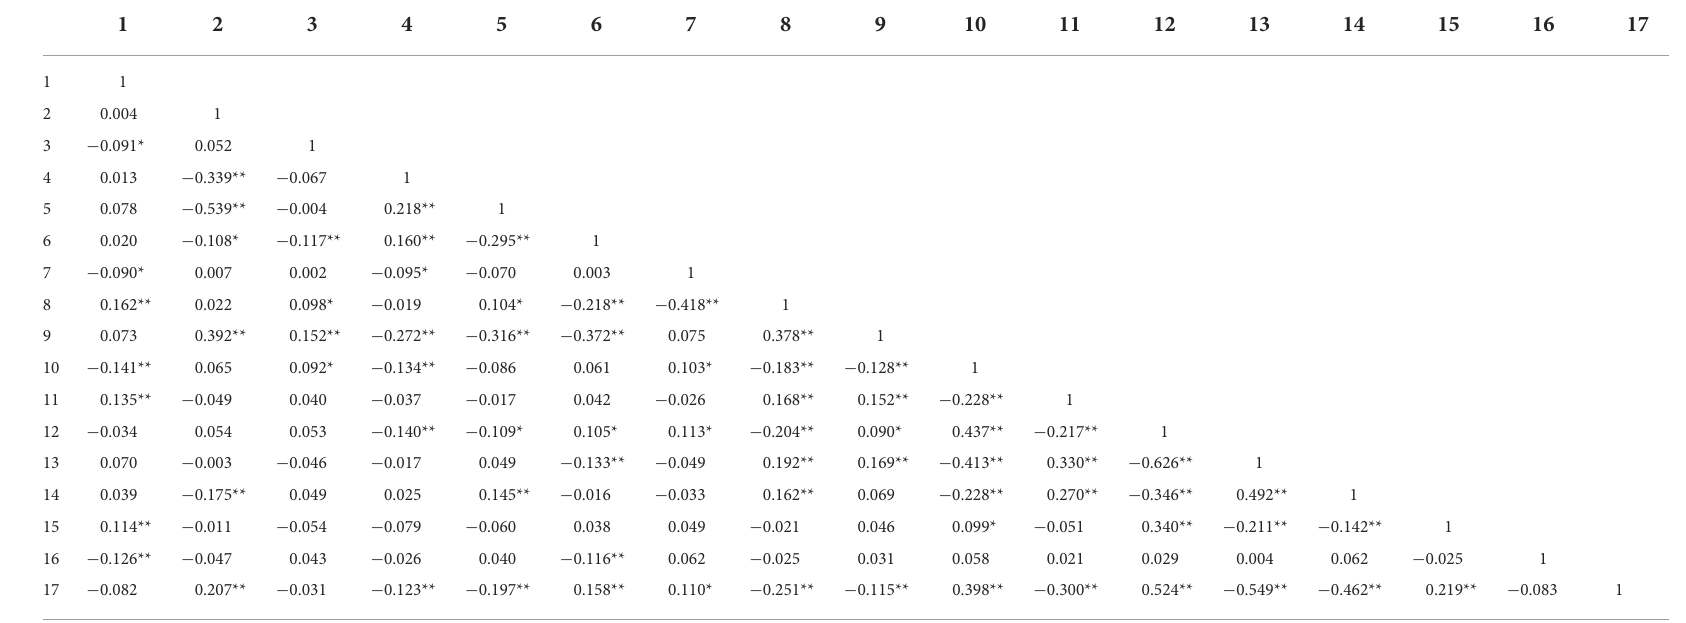
TABLE 2 Correlation